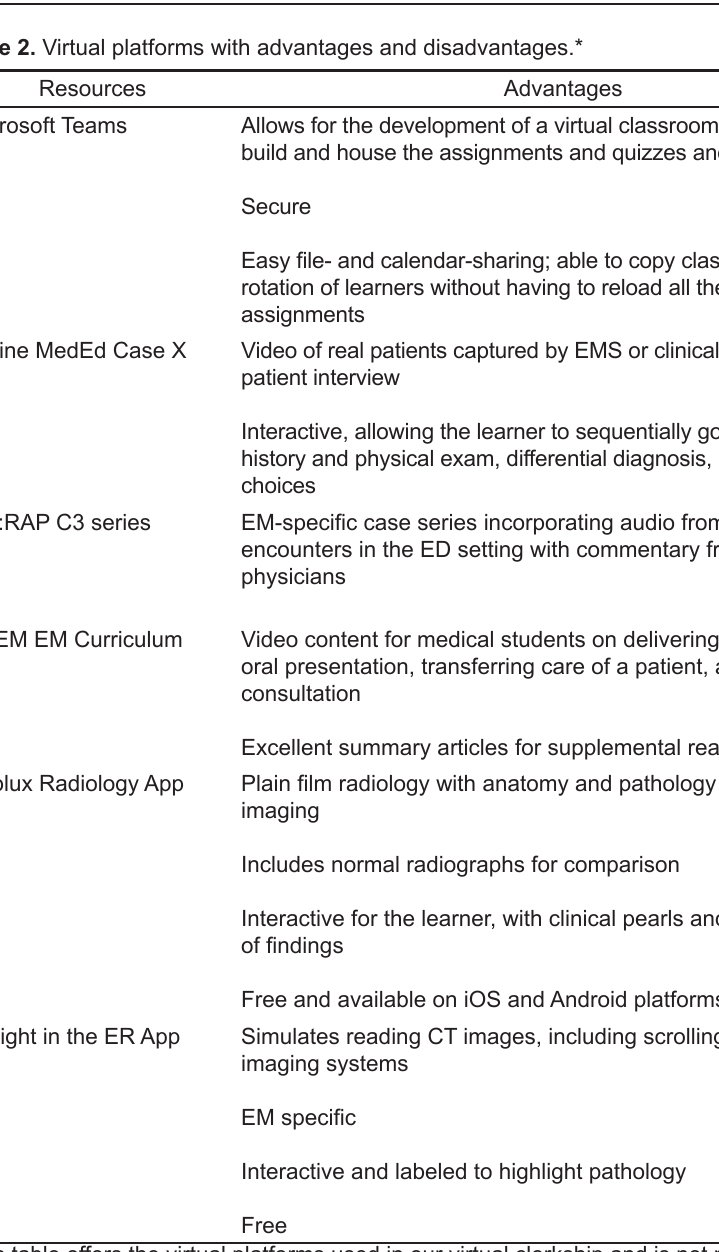
*This table offers the virtual platforms used in our virtual clerkship and is not meant to be a comprehensive list of all available platforms for online emergency medicine